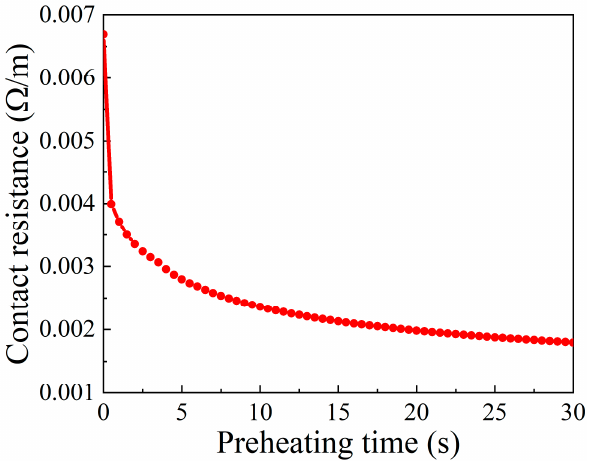
Figure 9. The variation of contact resistance respect to time during the preheating stage.